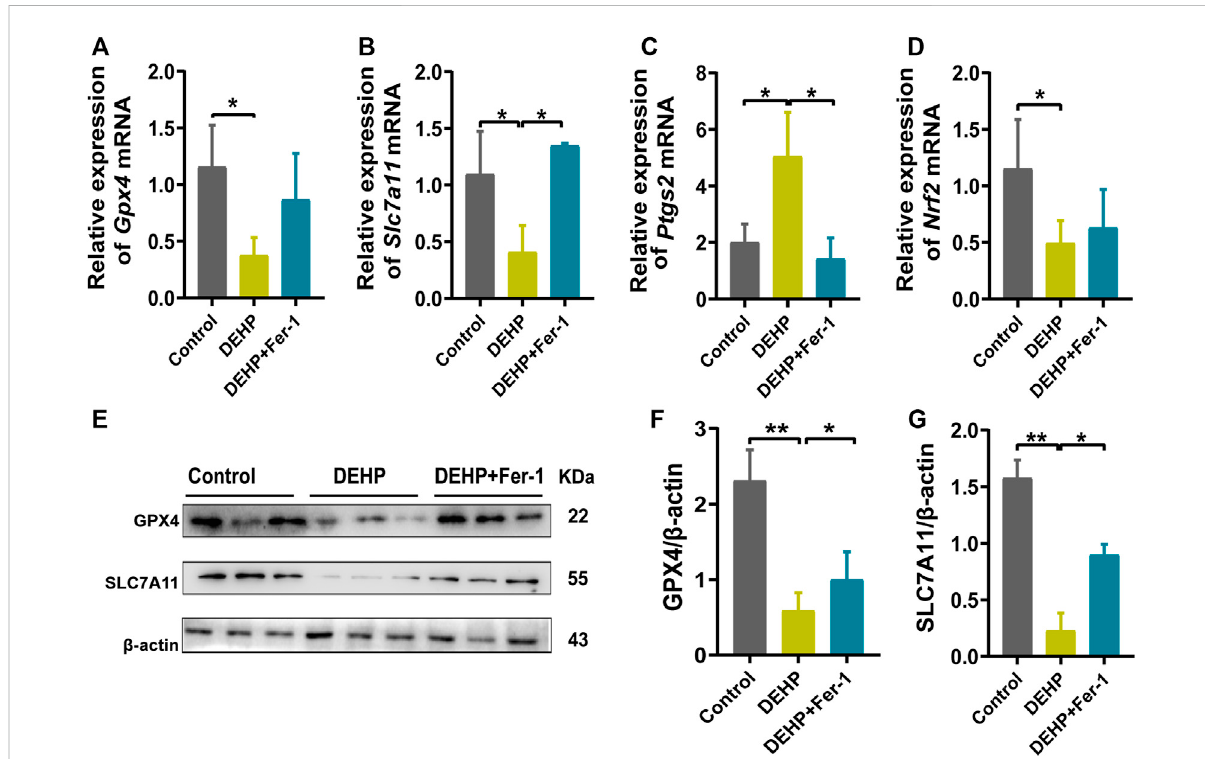
FIGURE 5 Fer-1 attenuated DEHP-induced ferroptosis and the activation of ferroptosis related gene expression. (A – D) mRNA levels evaluated by RT ‒ qPCR of the selected ferroptosis genes Gpx4, Slc7a11, Ptgs2, and Nrf2 in the control, DEHP, and DEHP+Fer-1 group. β -actin was used as the reference gene. (E) Protein levels of GPX4 and SLC7A11 in the livers of mice; β -actin was used as the reference protein. (F, G) Quanti fi cation of the protein levels of GPX4 and SLC7A11 in the livers of mice. Experiments were repeated at least three times. Data are presented as the mean ± SD. * p < 0.05, ** p < 0.01, *** p <